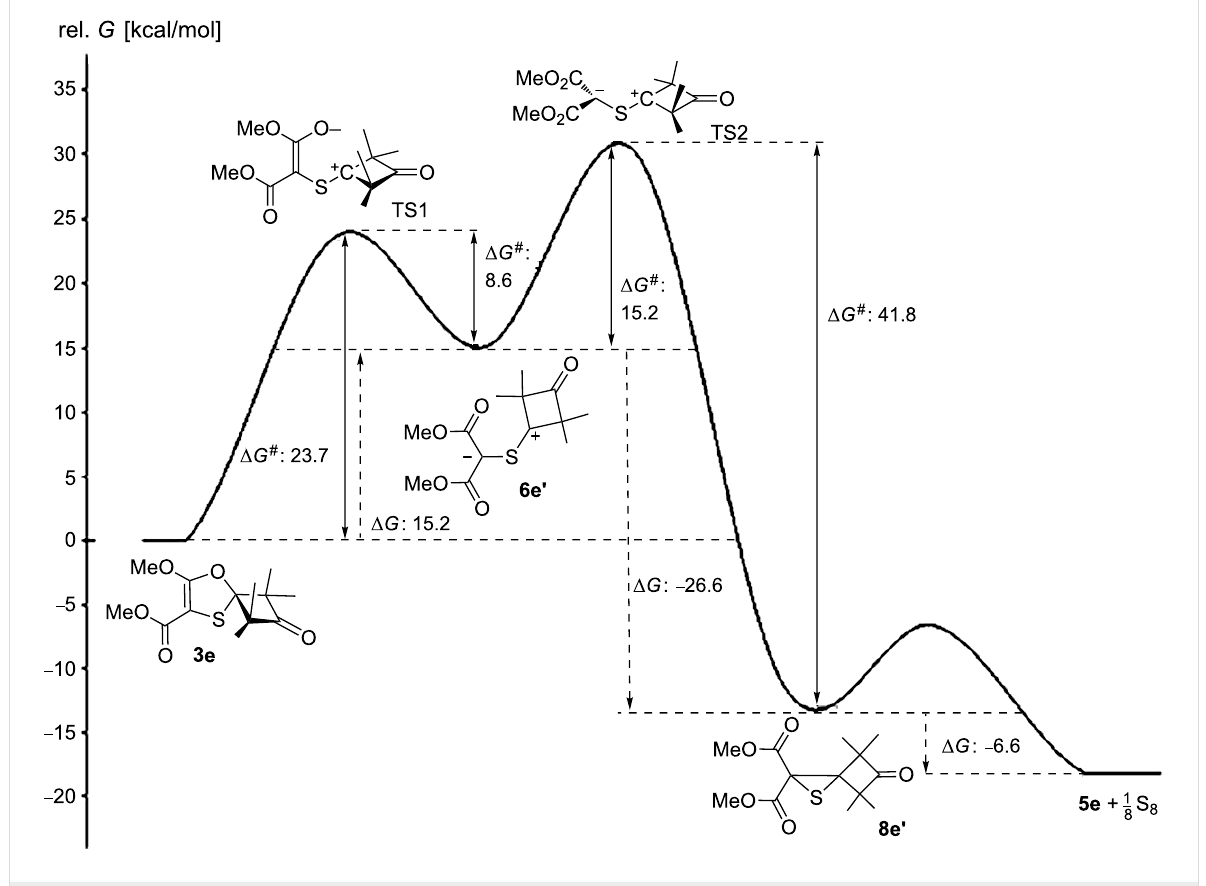
Figure 3: Energy profile for the transformation of 1,3-oxathiole 3e to alkene 5e . Relative free energies (kcal·mol − 1 , 298 K) computed at the DFT PBE1PBE/6-31G(d) level.